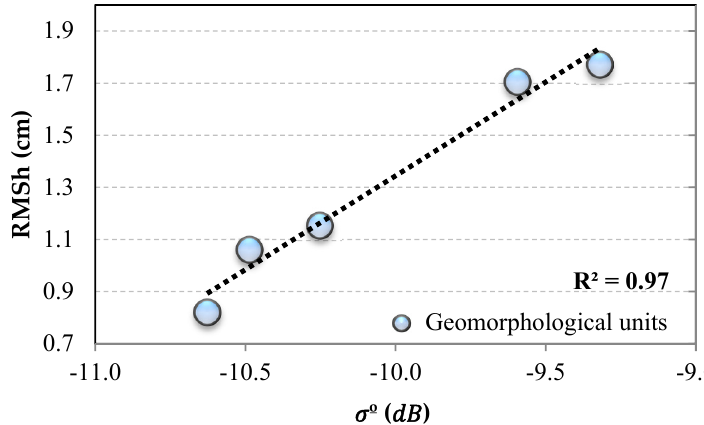
Figure 6. Correlation ( R 2 = 0.97) between the COSMO-SkyMed backscatter and the surface roughness as measured in the field (root mean square heights (RMSh)).